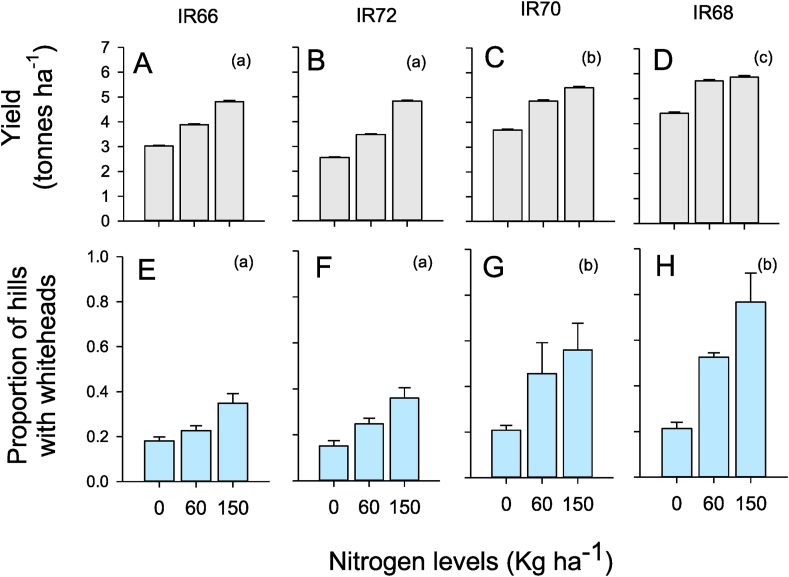
Yields of (A) IR66, (B) IR72, (C), IR70 and (D) IR68 in field plots treated with three levels of nitrogenous fertilizer. The proportion of whiteheads per hill is also indicated for (E) IR66, (F) IR72, (G) IR70 and (H) IR68. Field plots were treated with 0, 60 or 150 Kg of added nitrogen per hectare (N = 5). Standard errors are indicated and lowercase letters indicate homogenous variety groups (Tukey P > 0.05). See Table S4 for further details.